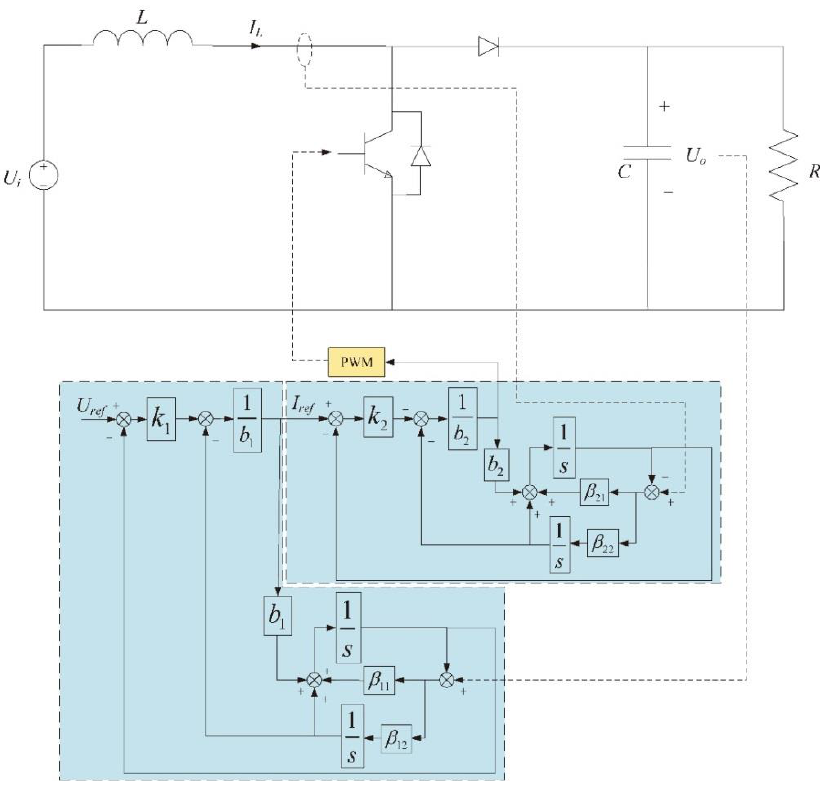
Figure 4. The structure of proposed controller.